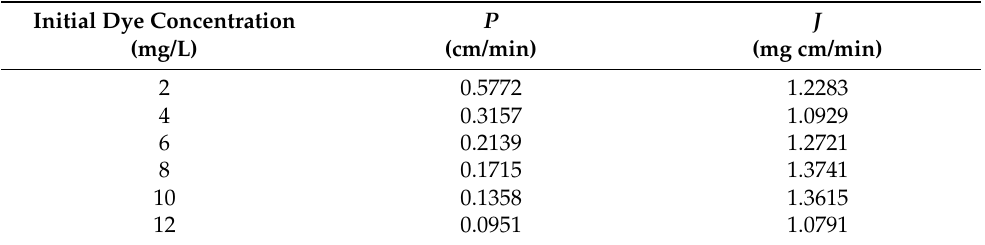
Table 4. Influence of the initial dye concentration on permeability ( P ) and flux ( J ) of the